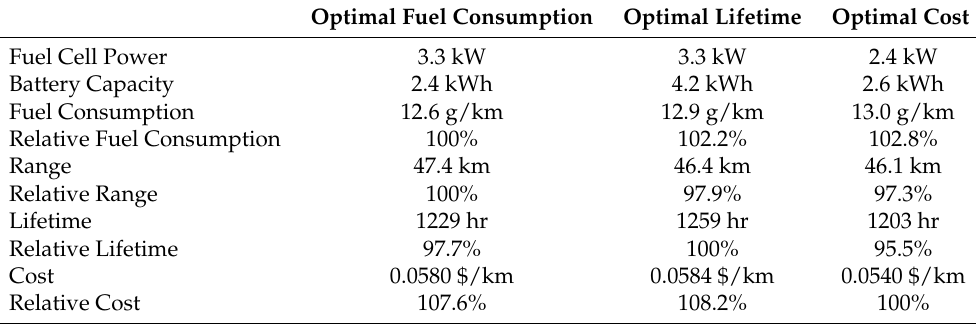
Table 2. Relative performance of each design.